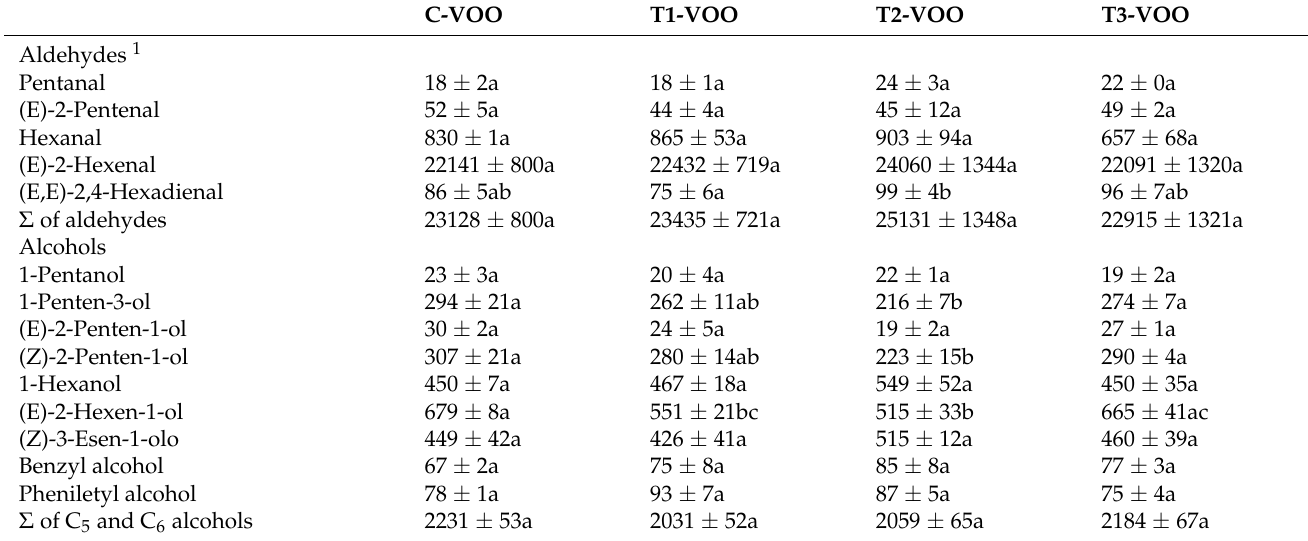
Table 4. Volatile composition ( µ g/kg) of Moraiolo VOOs extracted at different